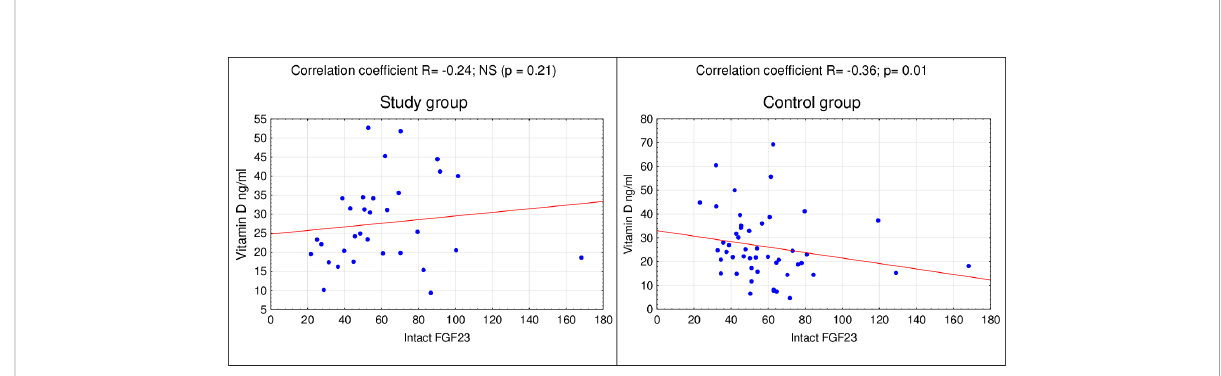
FIGURE 1 Correlation of FGF23 and vitamin D in the study and control